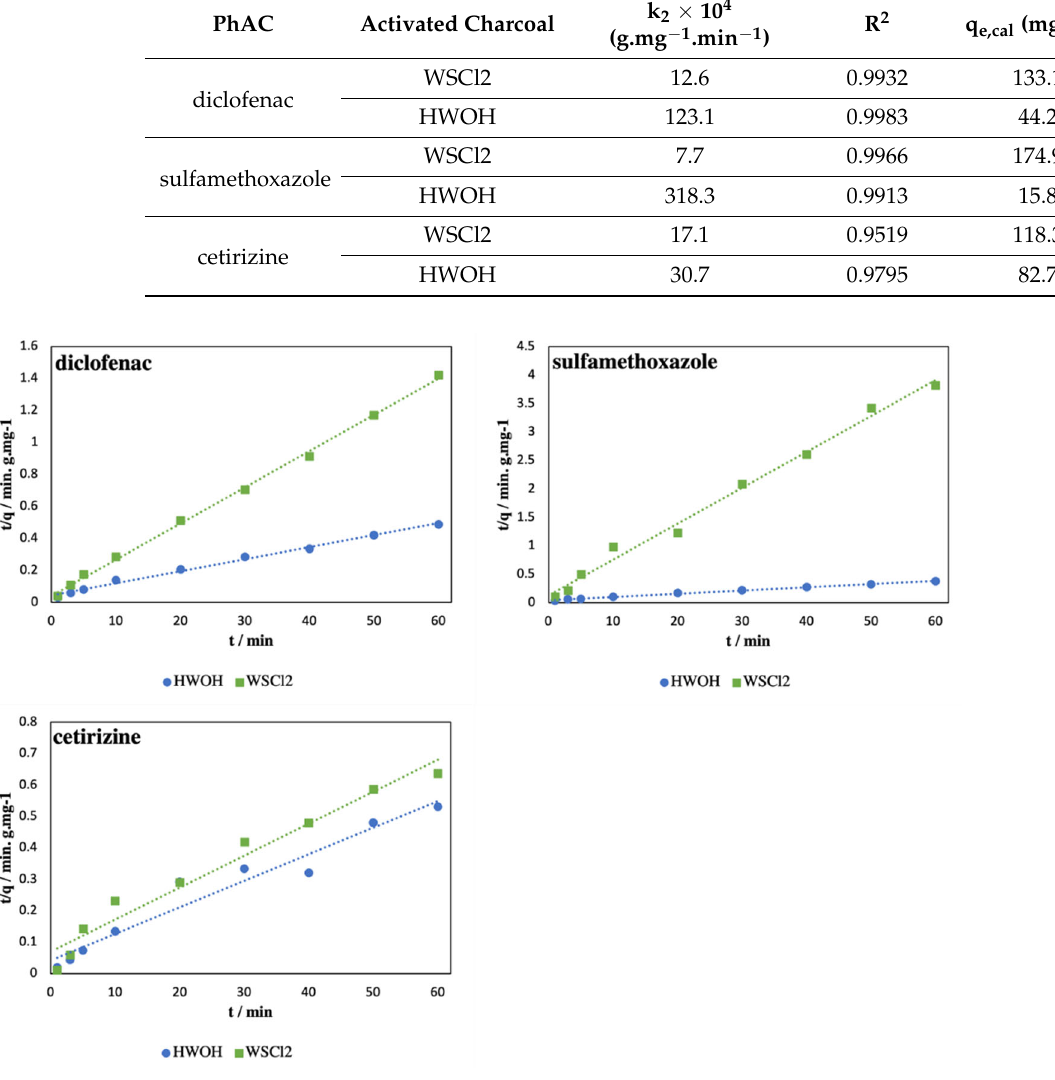
Figure 2. Adsorption kinetic plotted as a ratio of time (t) to uptake at given time (q) to time for two adsorbents (WSCl2 and HWOH) and three chosen pharmaceuticals (diclofenac, sulfamethoxazole and cetirizine). Table 5. Kinetic data of adsorption of diclofenac, sulfamethoxazole, and cetirizine on two activated charcoals fitted to the pseudo ‐ second order.